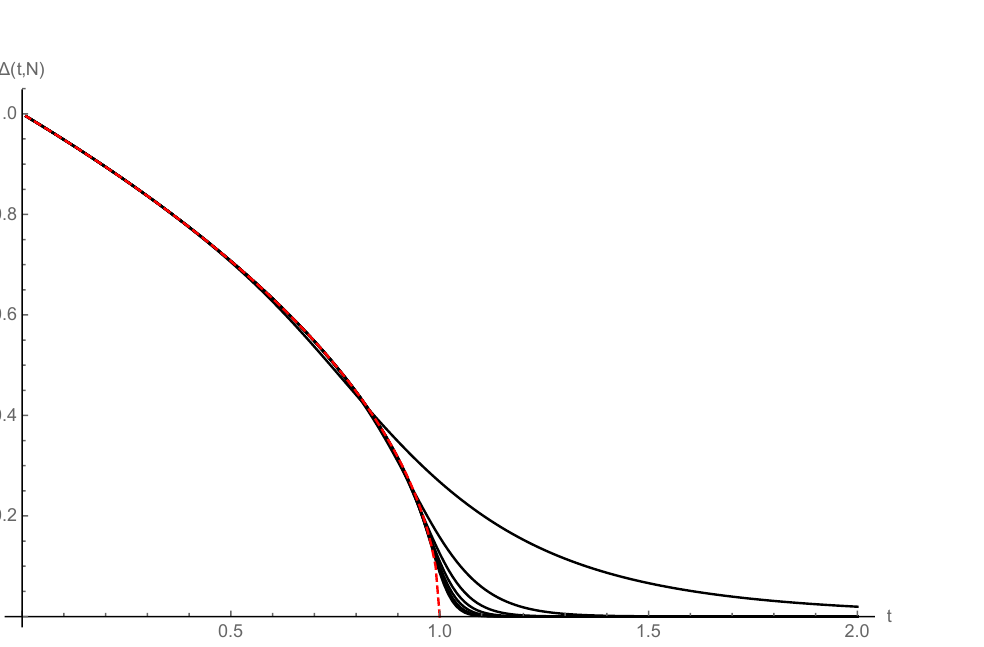
Figure 7 . The dependence of (cid:1)( t; N ) (cid:17) h det U i on the ’t Hooft coupling t , for various values of N . The values of N plotted are N = 5 ; 25 ; 50 ; 75 ; 100 ; 125 ; 150, with the black curves lowering monotonically towards the N = 1 result in (5.21). The red dashed curve shows the in(cid:12)nite